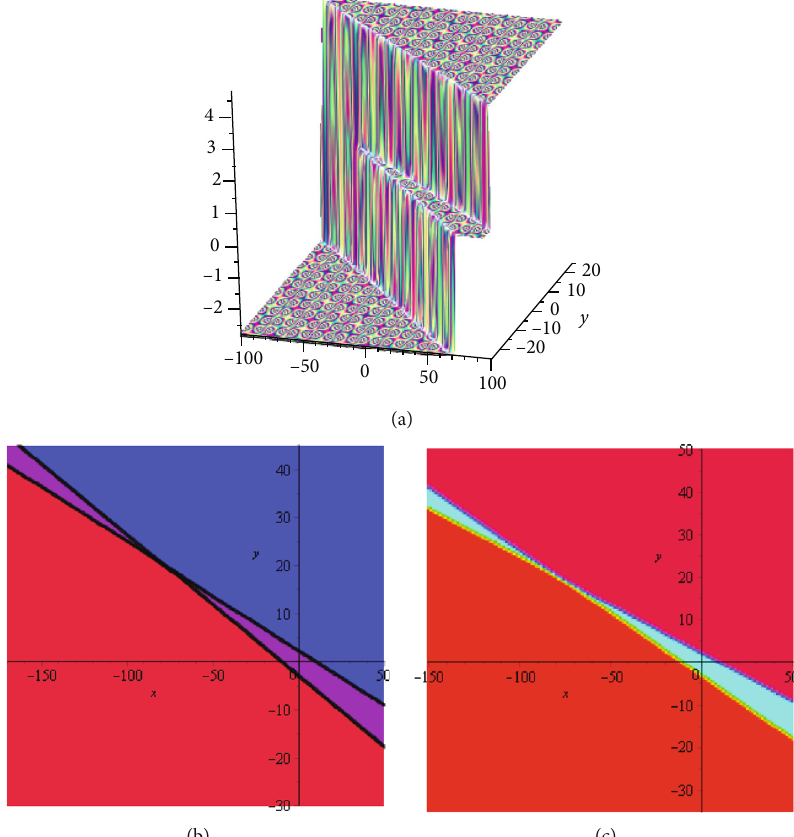
= : 5, a = 1 : 5, a = 2, a = 1, Ω = 1 : 9, Ω = : 2, Ω = 2, δ = 1, δ = 1 : 3, δ 1 2 3 4 1 5 9 1 2 3